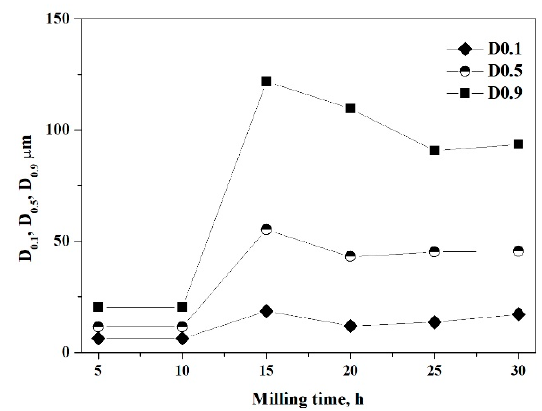
Figure 6. Particle sizes D 0.1 , D 0.5 , and D 0.9 of the composite as a function of the milling time (D 0.1 , D 0.5 , and D 0.9 diameters correspond to 10, 50, and 90% fineness of the particle size volume distribution, respectively).